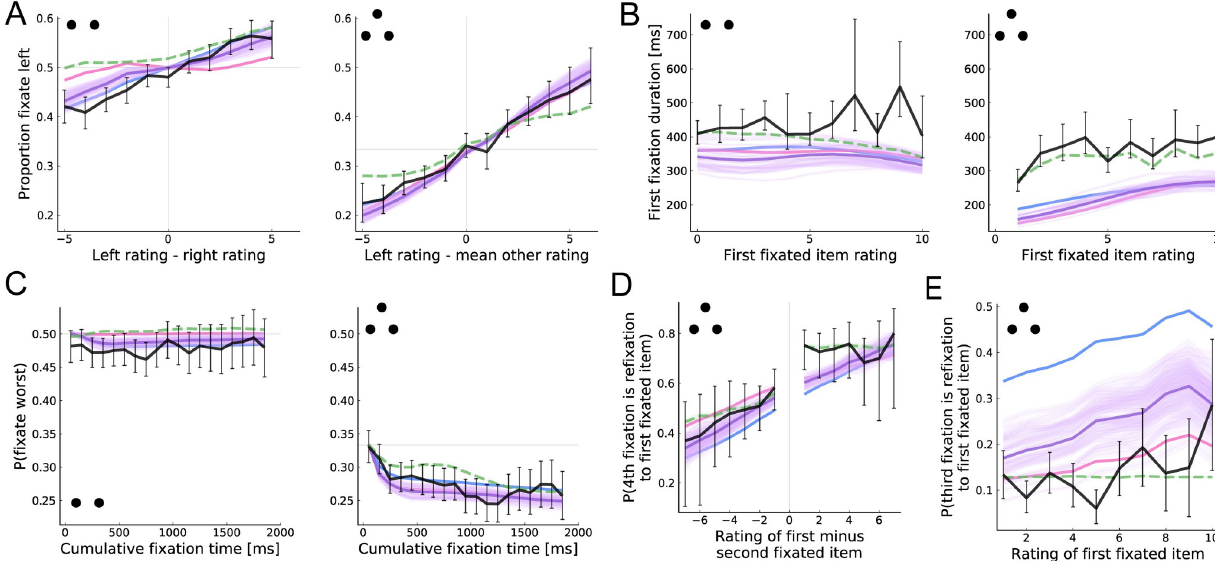
Fig 6. Value-directed attention. (A) Proportion of time fixating the left item as a function of its relative rating. (B) First fixation duration as a function of the rating of the first-fixated item. (C) Probability of fixating the lowest rated item as a function of the cumulative fixation time to any of the items. (D) Probability that the fourth fixation is to the first-fixated item as a function of the difference in rating between that item and the second-fixated item. (E) Probability that the third fixation is to the first fixated item as a function of its rating. See Fig 3 for more details.